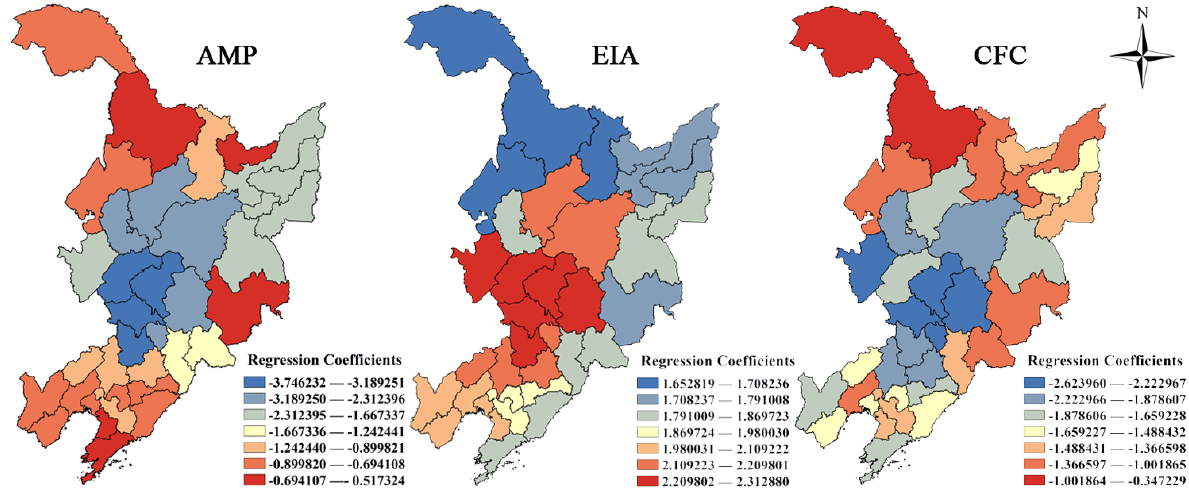
Figure 7. Spatial distribution of regression coefficients of agricultural inputs in